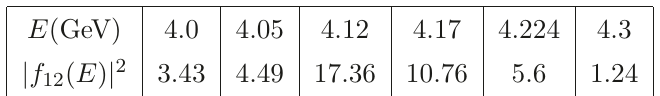
Table 2 . The values of the 2) E 1 (th) = 3 . 936 , E 2 (th) = 4 . 12 , µ 1 = 0 . 767 , µ 2 = 0 . 984 , ν 1 = 0 . 96 , ν 2 = 0 . 87 , z = 1